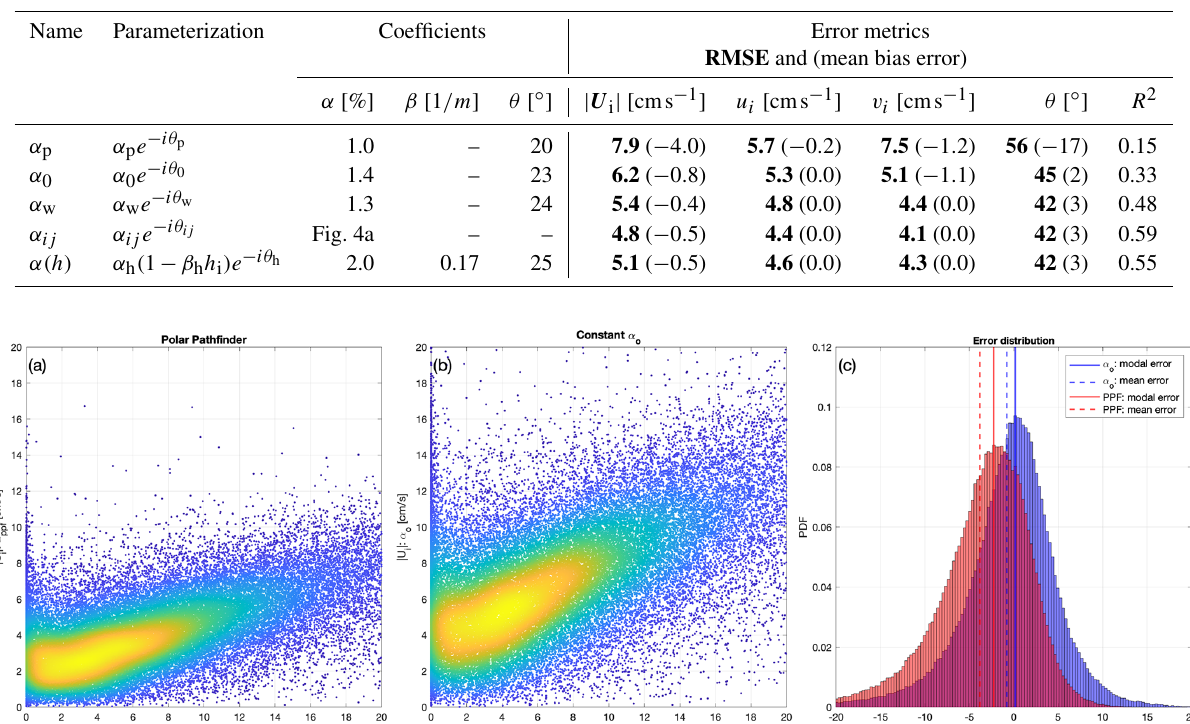
Table 1. Values obtained from a least-squares fit using buoy data (IABP), 10m wind velocity (ERA5), and ice thickness (PIOMAS) over the 1979–2019 period (with the exception of α p for which the values are prescribed). These parameterizations include the Polar Pathfinder free-drift input data ( α p ); a bias-corrected, constant wind–ice–ocean transfer coefficient, ignoring ocean currents ( α 0 ) and permitting ocean currents ( α w ); spatially varying transfer coefficients, turning angles and ocean currents ( α ij ); and a thickness-dependent free-drift parame- terization ( α h ). The five rightmost columns present the root-mean-square error (RMSE, bold font) and mean bias error (in parenthesis) on drift speed, u and v components, drift angle, and the explained variance ( R 2 ), evaluated at the IABP buoy data locations.